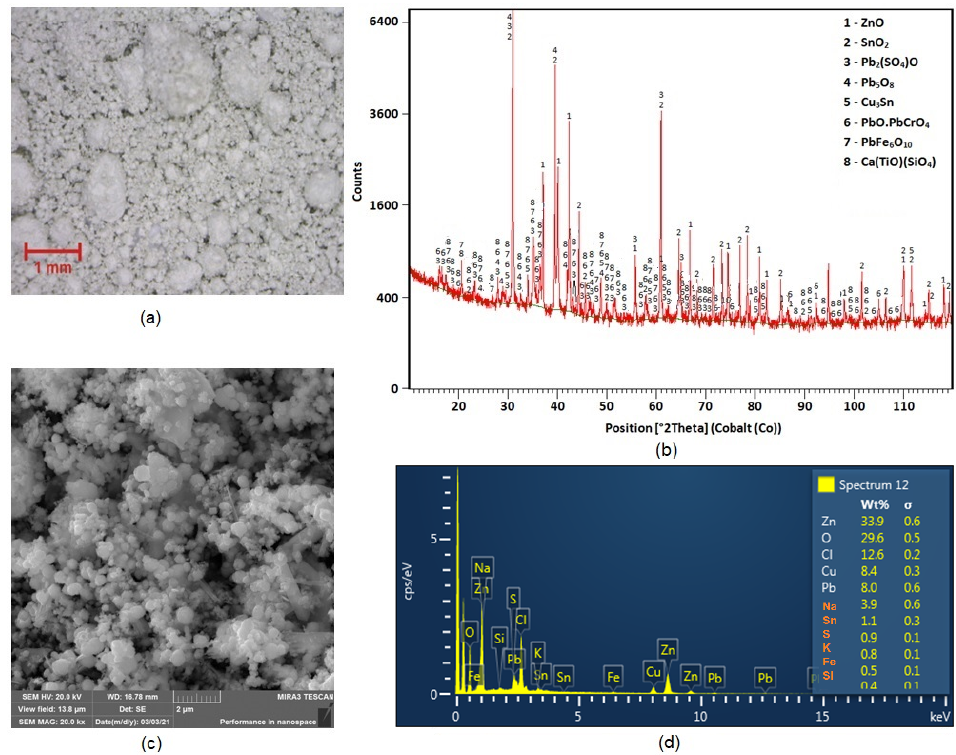
Figure 2. ( a ) Morphology of converter dust particles under stereo microscopy; ( b ) XRD analysis results; ( c ) SEM analyses, morphology of particles and ( d ) EDX analyses.